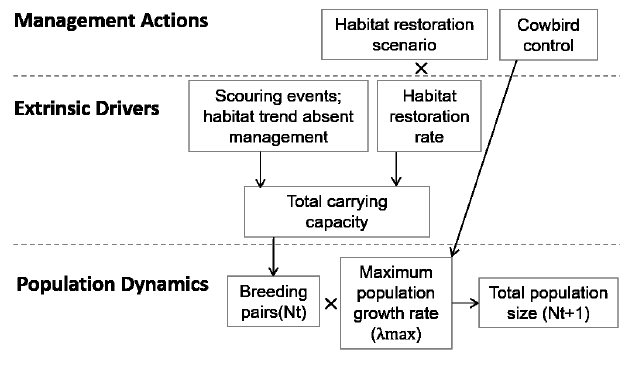
Fig. 2 . Schematic of simplified population growth model. See text for model details and parameter descriptions.